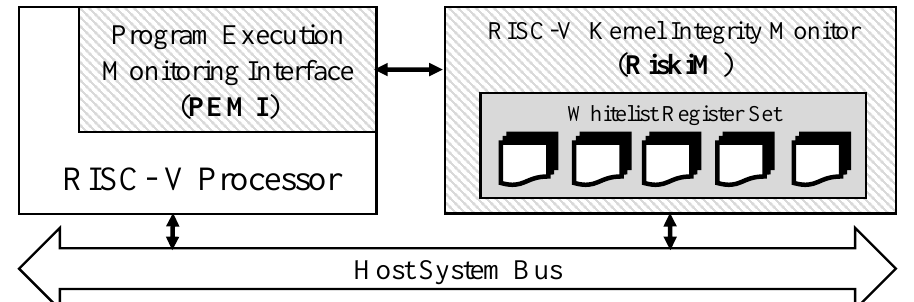
Figure 1. The architecture overview of our